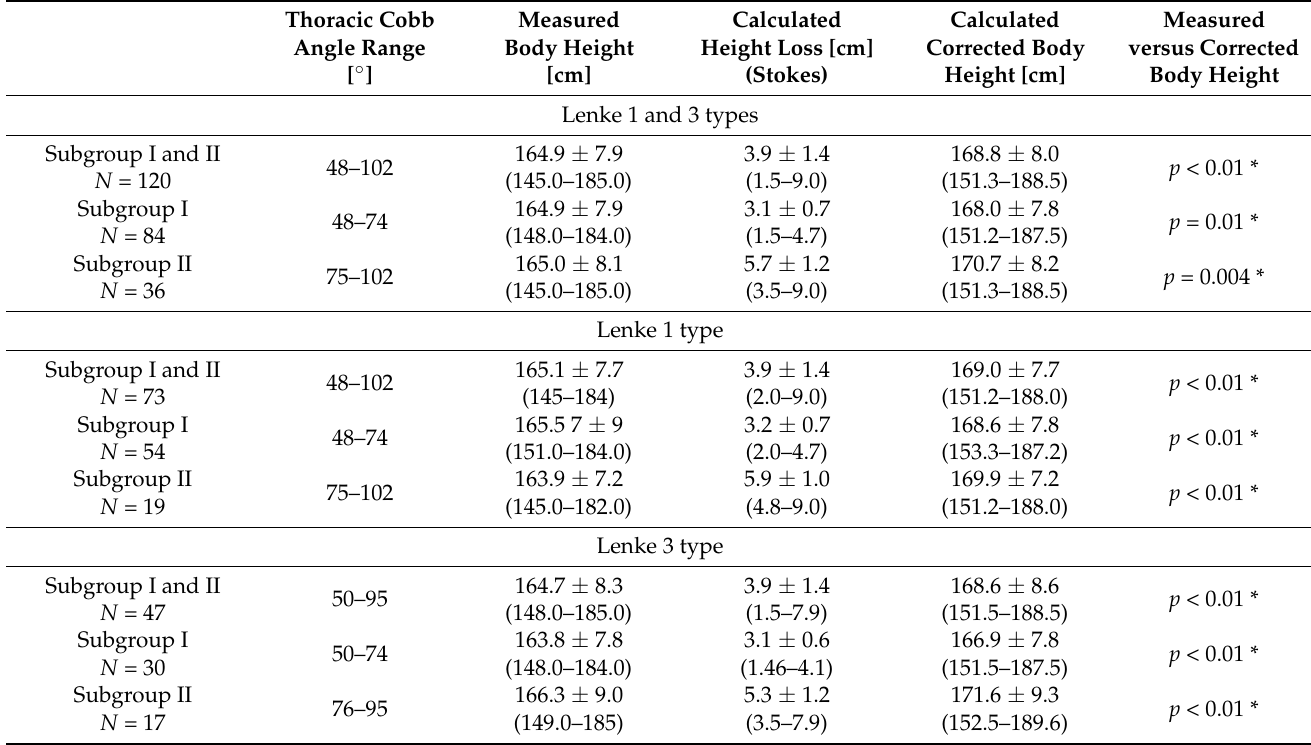
Table 1. Comparison of the measured body height versus the calculated corrected body height.